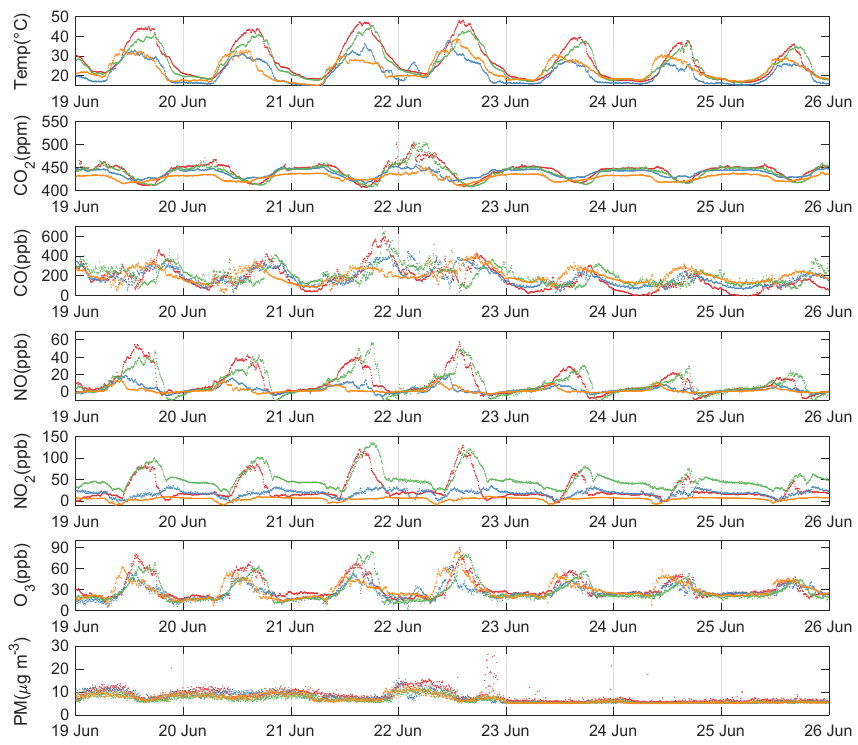
Figure 7. Time series of fully calibrated 5min averaged BEACO 2 N data from a representative week at four sites deployed in 2017. Obser- vations from the Hercules, Ohlone, Washington, and Madera sites are plotted in red, green, orange, and blue, respectively. Particulate matter is converted to units of mass concentration according to Holstius et al. (2014).